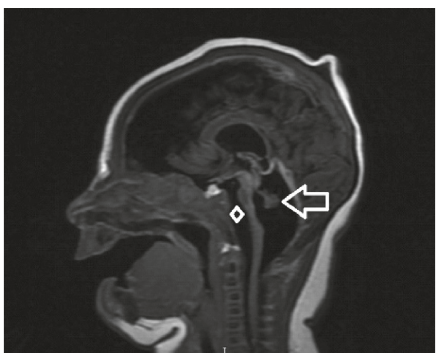
Figure 1: T1 sagittal image showing near complete absence of cerebellum with rudimentary anterior vermis (arrow).There is also marked hypoplasia of the pons also seen in the image